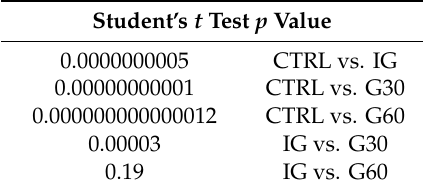
Table 2. Student’s t test results for each comparison tested.